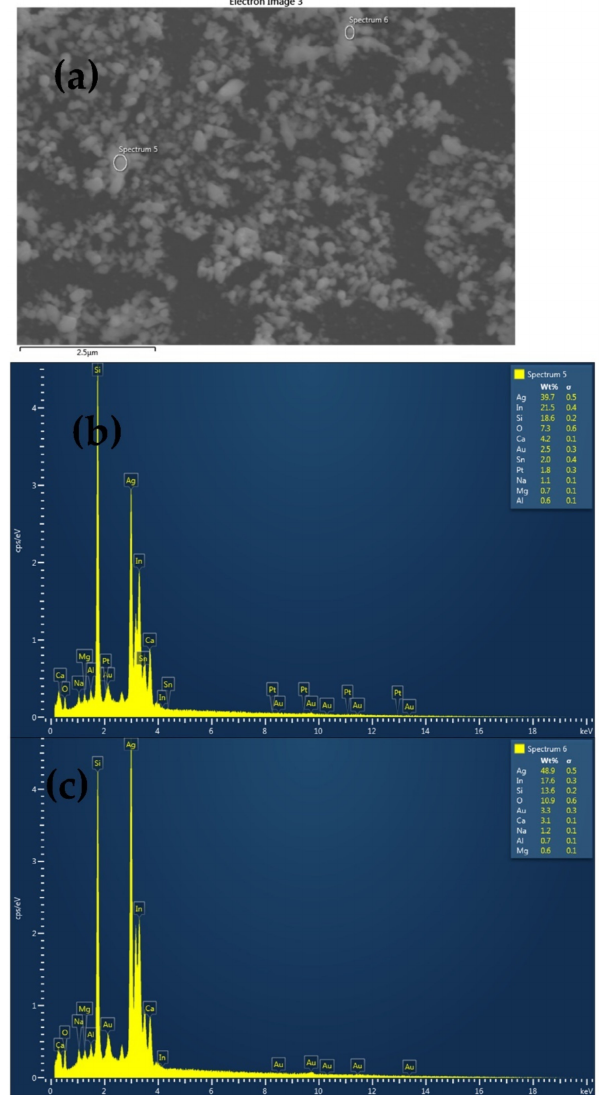
Figure 3. EDX spectra on different positions of the sample. ( a ) SEM image shows the two locations where the EDX spectra were measured, scale bar 2.5 µ m and magnification 5000 × . ( b , c ) EDX spectra of the two positions indicating the presence of silver, gold, and